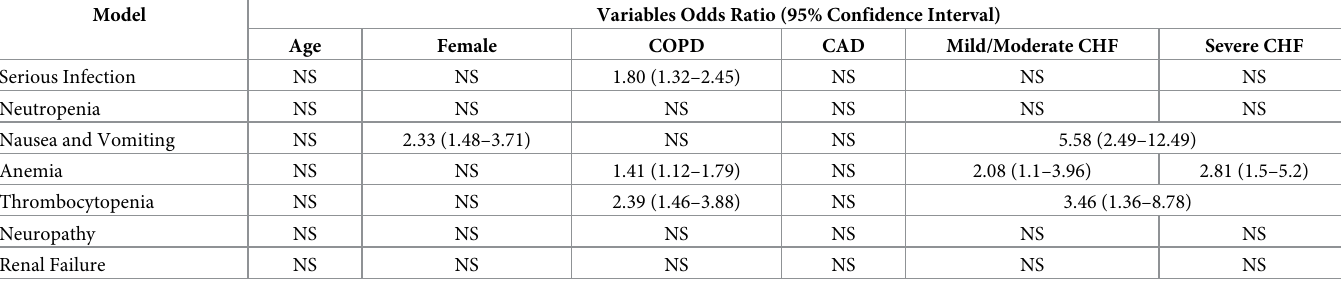
Table 3. Adjusted risk factors of major adjuvant chemotherapy complications in lobectomy patients who underwent adjuvant chemotherapy (n = 2,301). Model